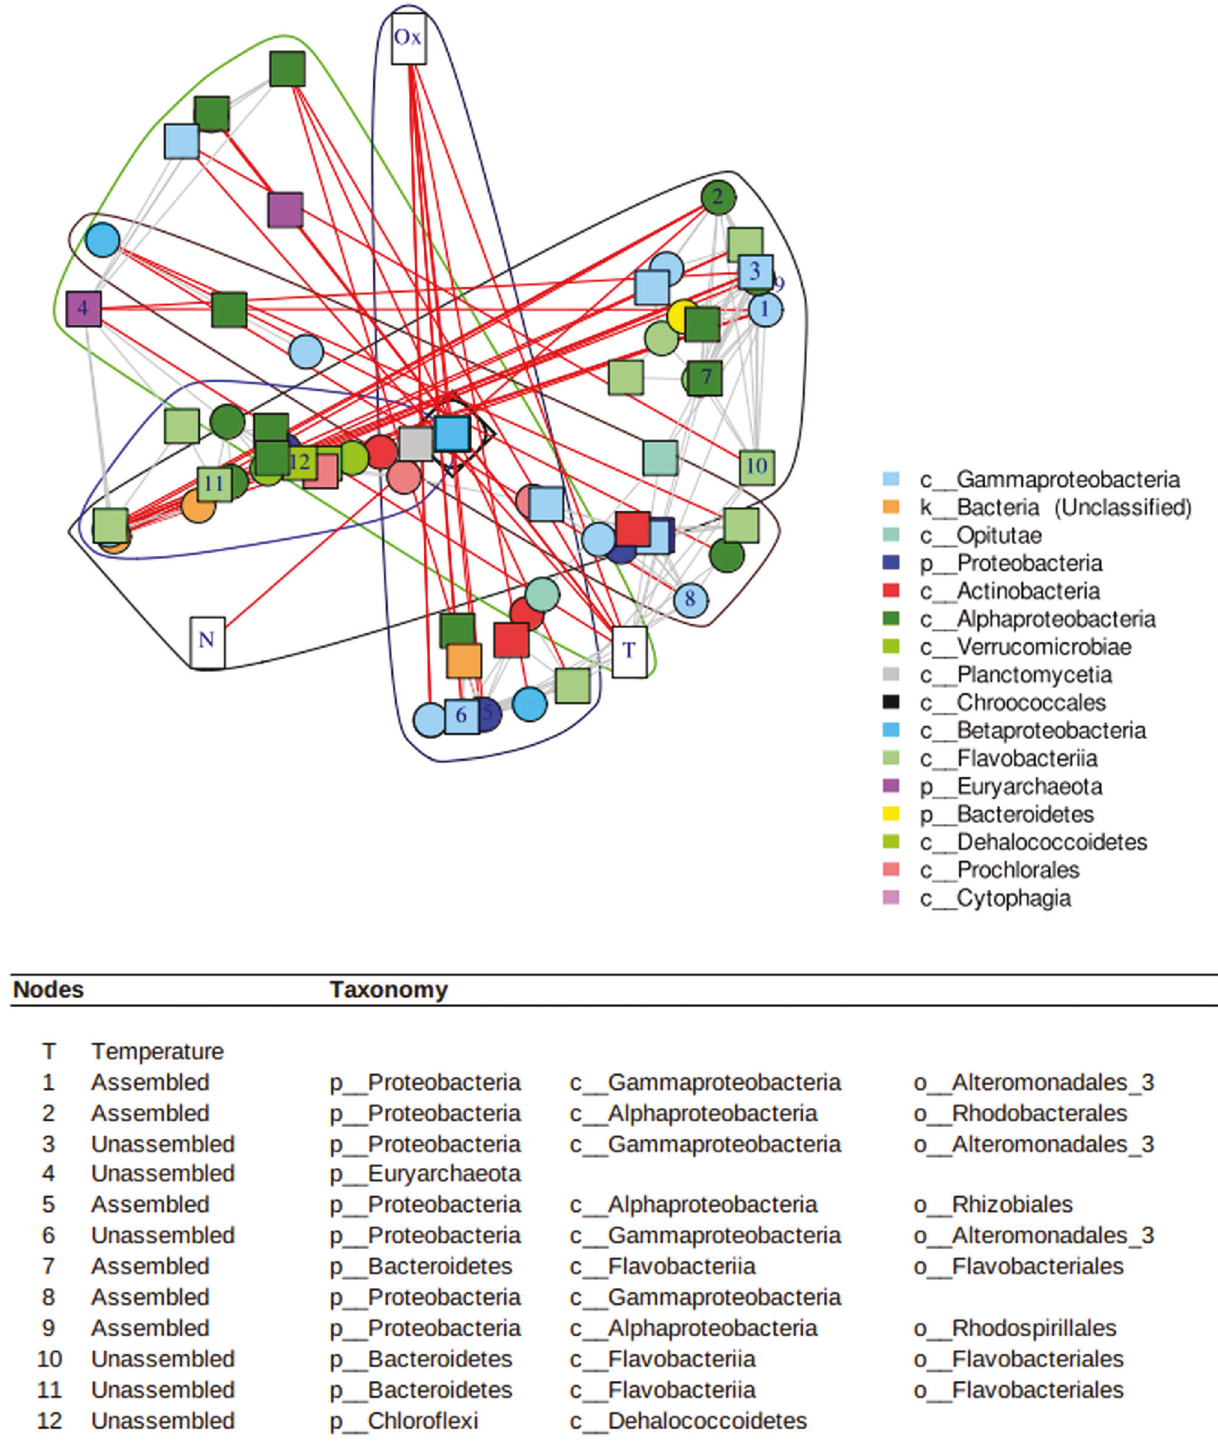
Fig. 6 Network representation of the relationship between uCAG (square vertices), aCAG (circle) and physicochemical parameters (rectangle, T: temperature, Ox: oxygen and N: nitrite) and Louvain clusters. Red lines between nodes indicate negative Spearman correlations whereas gray edges correspond to positive correlations. The table below the graphics shows the best keystones in the network inferred from the « ExpectedIn fl uence » parameter (see Fig. S8). The numbers in the fi rst column correspond to the numbering of the vertex in the